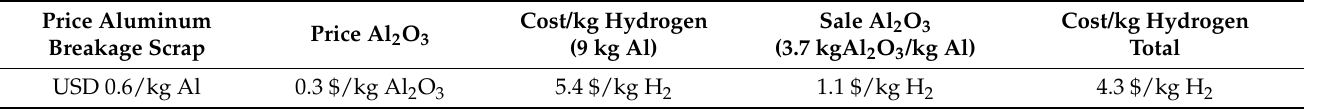
Table 10. Cost of aluminum green